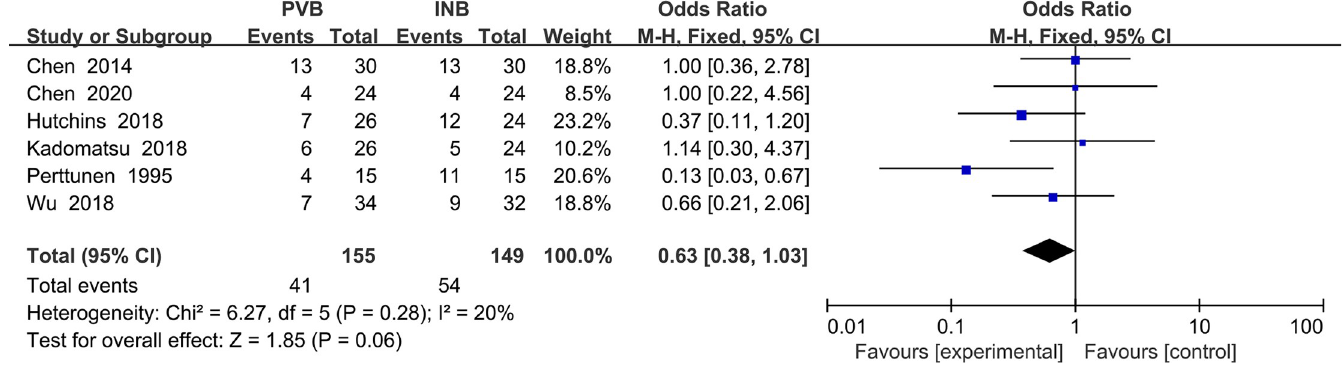
Fig 16. Forest plot of comparison: PVB VS INB. Outcome: Rates of postoperative nausea and vomiting.